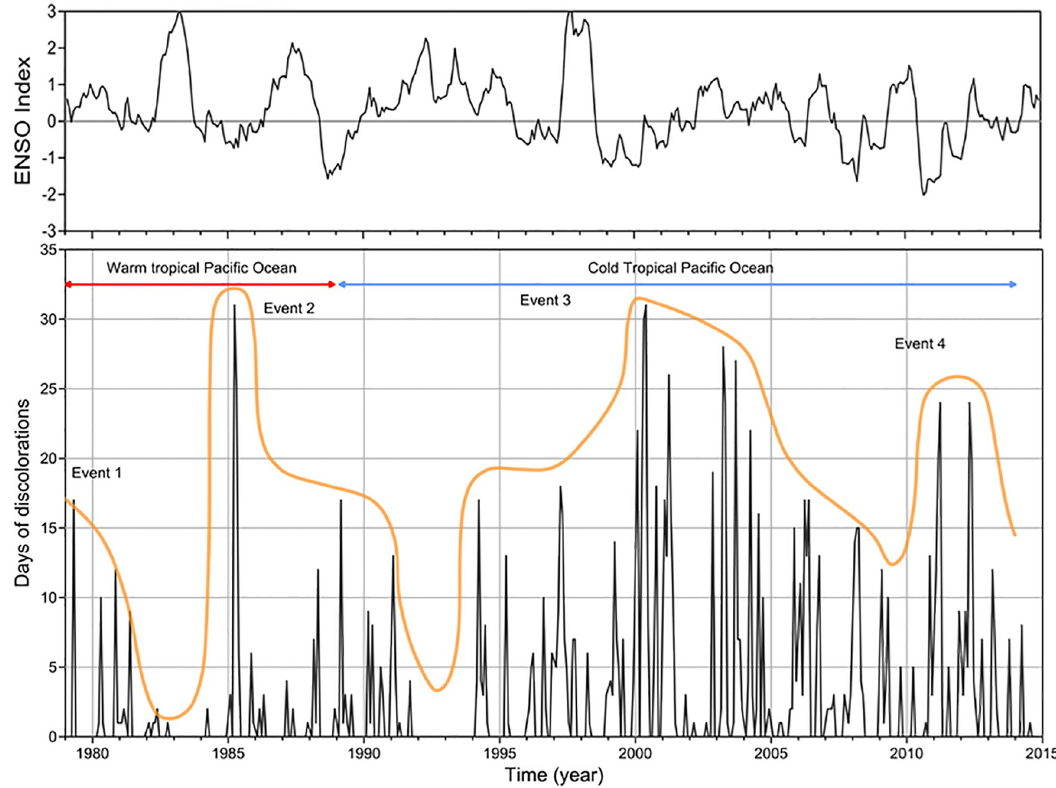
Fig 2. Days of discoloration by month; the yellow line is the arbitrary envelope of the big events. The thermal characteristics of the Pacific Ocean according to the PDO are shown at the top. Upper panel trend of multivariate ENSO (MEI